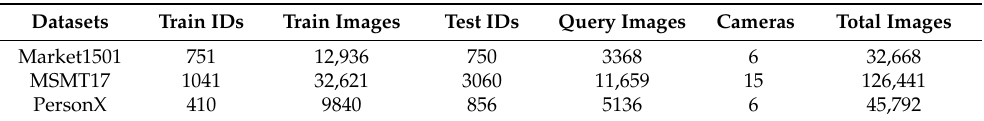
Table 1. Experimental